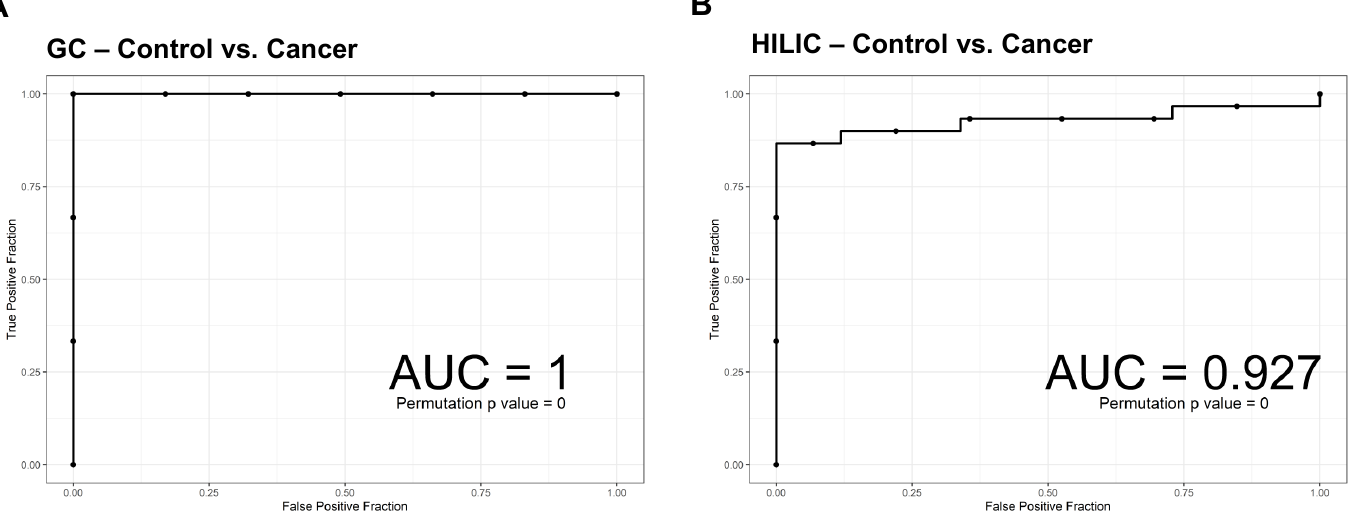
Figure 4. ( A , B ) Receiver operating characteristic (ROC) curves of support vector machine (SVM) with leave-one-out cross-validation of the area under the curve (AUC) using metabolites with adjusted p -values less than 0.05 in the GC ( A ) or HILIC platforms ( B ), respectively.